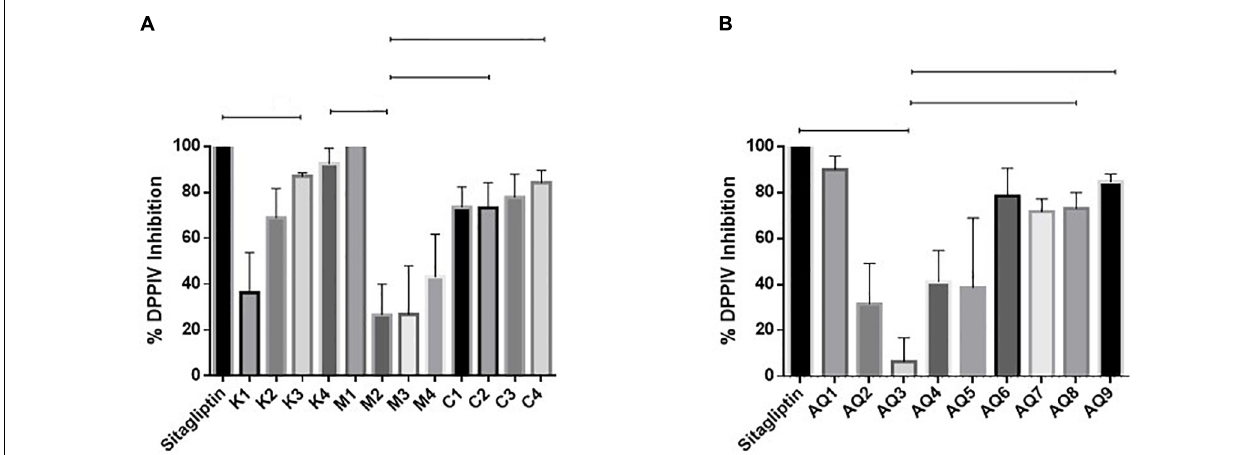
FIGURE 3 | (A,B) Dipeptidyl peptidase enzyme (DPP-IV) inhibition by mesopelagic Hydrolysates generated from Krill (K), M. muelleri (M), and a combination of both (C). Aqueous extracts (AQ). (A) One way ANOVA was done using Tukey’s multiple comparison test at α =